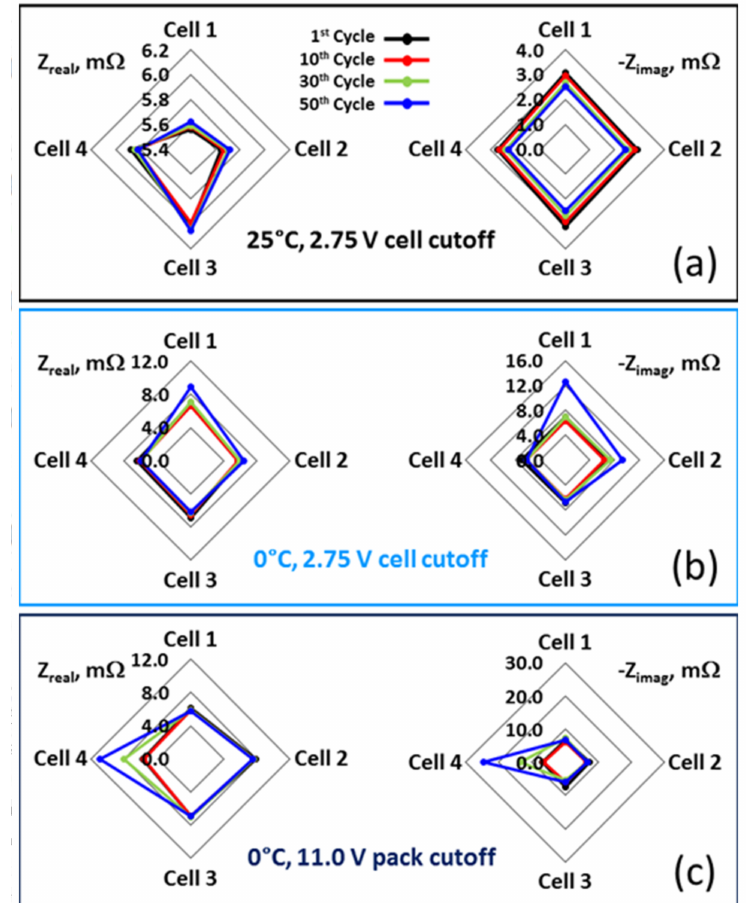
Figure 8. Radar plots showing progression of real (Z real ) and imaginary ( − Z imag ) impedance at f SOH = 316 Hz Cells 1–4 within 4S packs after the 1st, 10th, 30th and 50th discharge cycles at ( a ) 25 ◦ C; ( b ) 0 ◦ C with discharge cutoffs when the first cell reaches 2.75 V and ( c ) 0 ◦ C when the pack reached a voltage of 11.0